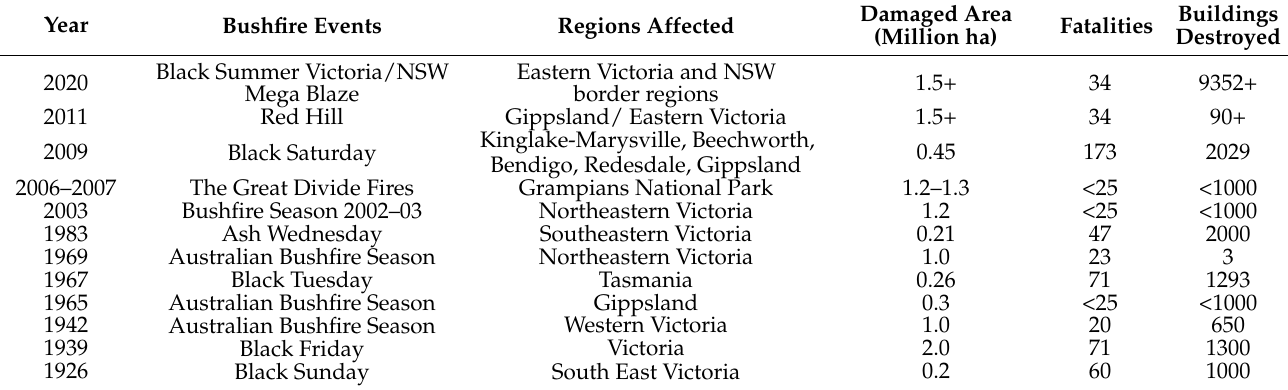
Table 2. Some of the devastating fire events of Victorian history (Source: Victoria government